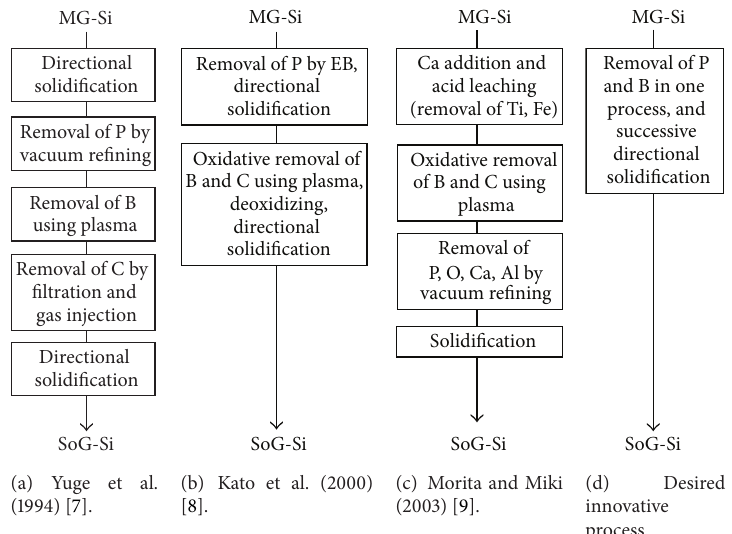
Figure 1: Proposed refining processes to purify MG-Si to SoG-Si.